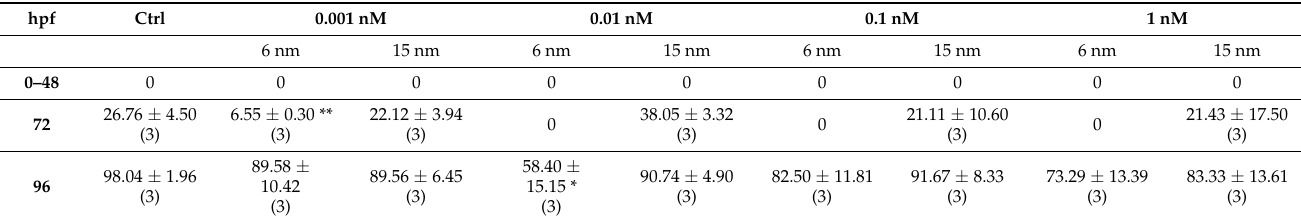
Table 3. Hatching percentage of embryos exposed to 0.001–1 nM of 6 or 15 nm GNP@PEG. Mean ± SE of three experiments. hpf